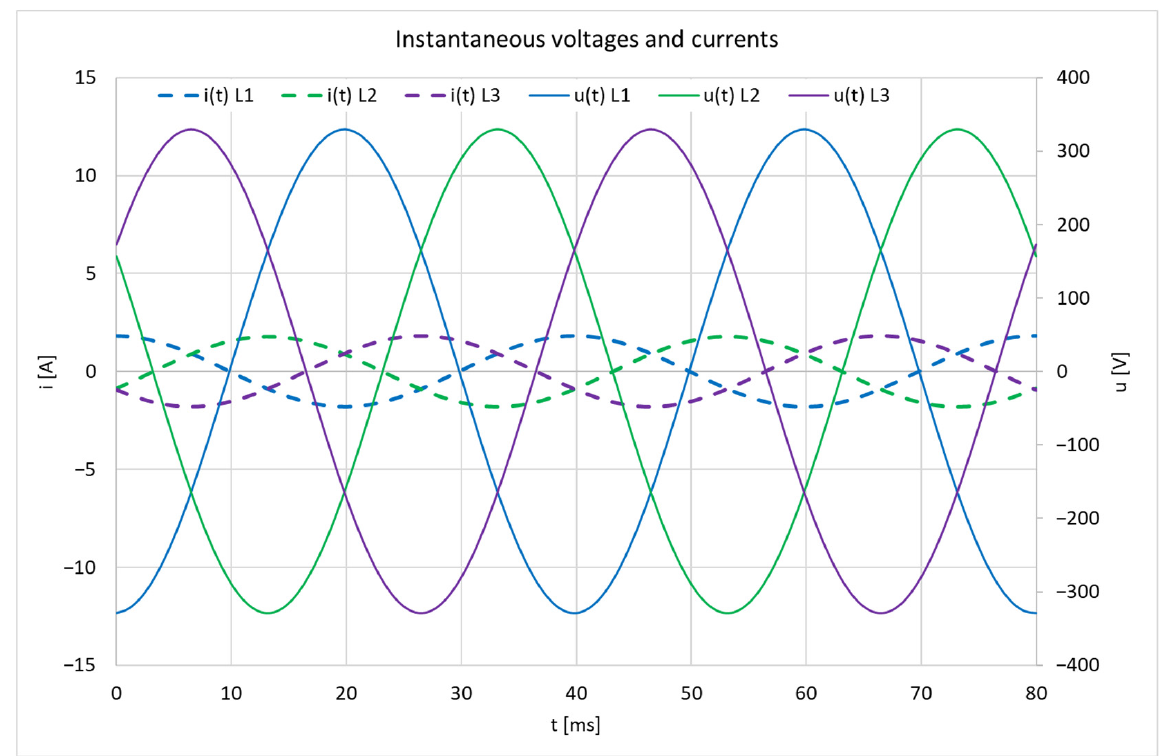
Figure 11. Instantaneous currents and voltages collected in the 10th hour of simulation in a single prosumer installation, the case of three-phase PV inverters and implemented control algorithm.